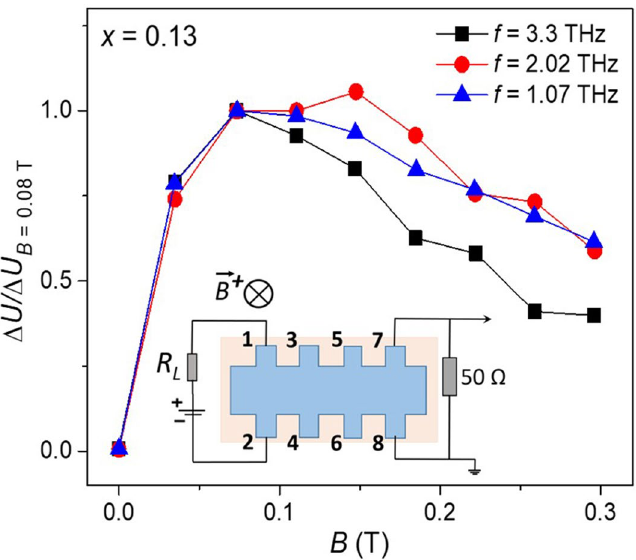
Figure 5. Magnetic field dependence of the effect amplitude taken at different laser frequencies. The effect amplitude is normalized to its value at B = 0.08 T. The data are taken for the contact couple (1–2) used as current leads and the contact couple (7–8) as photosignal leads, the magnetic field direction is B + (see the inset), the sample composition x = 0.13.